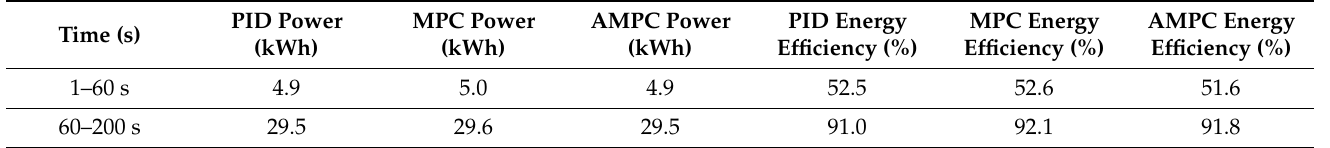
Table 2. Energy consumption and energy efficiency of heated orange juice using PID, MPC, and AMPC controller.